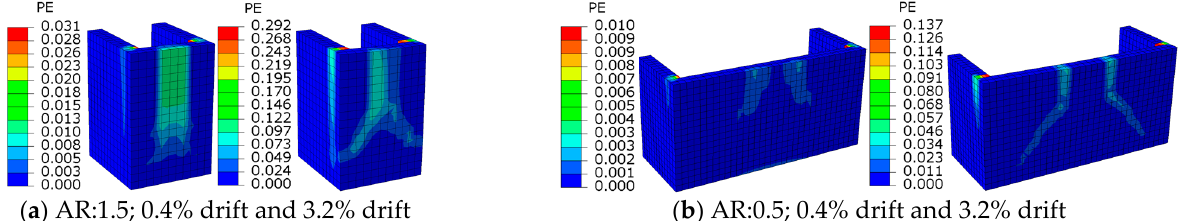
Figure 13. The influence of the aspect ratio (AR) on the strain distribution of the wall.